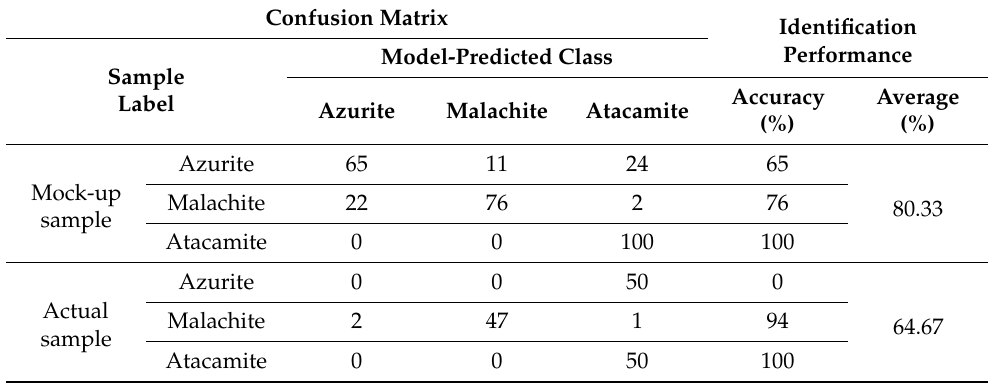
Table 1. Confusion matrix and accuracy of KNN identification model for three